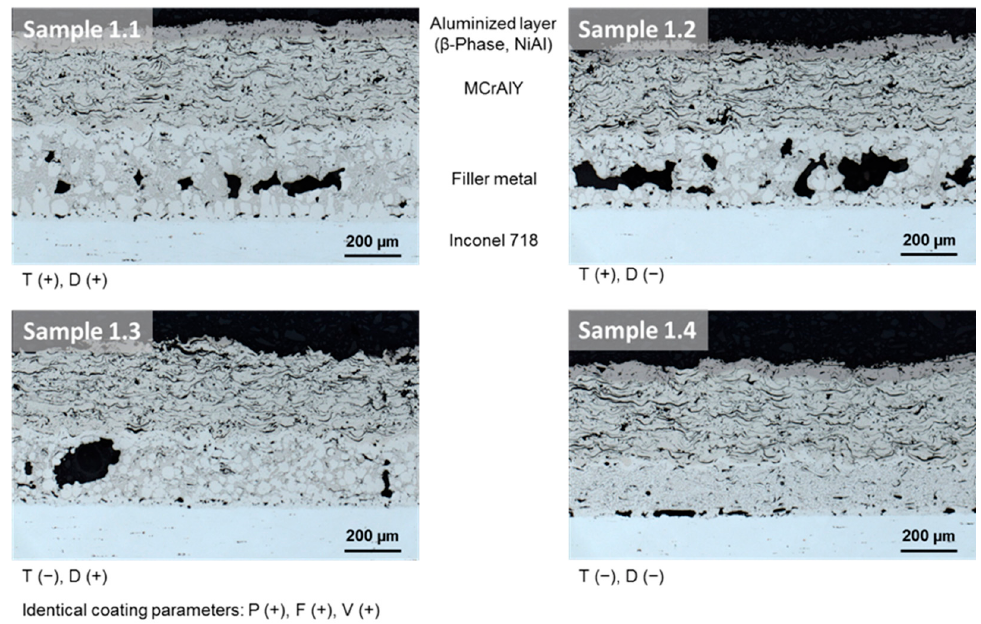
Figure 7. Optical micrographs of cross sections of brazed/aluminized samples (coarse powder; different heat treatment but identical coating parameters).